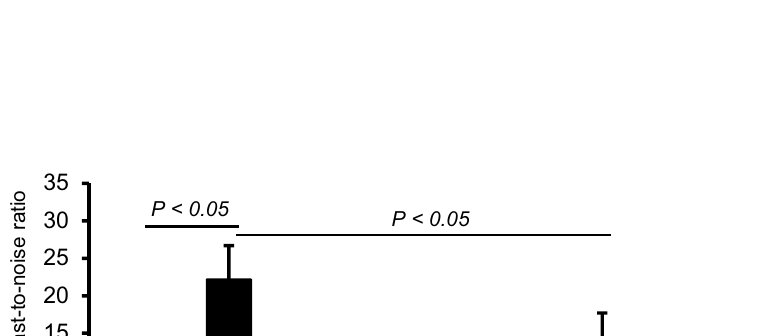
Figure 3. Laser ICP-MS for the assessment of the gadolinium distribution in the periablational rim. ( A1 , A2 ) Morphologic images show an overview of the location of the ablation zone, the periablational rim and the healthy liver tissue (( A2 ) magnification). ( B1 ) Gadolinium-specific LA-ICP-MS confirmed the high signal of the elastin-specific probe in the periablational rim (green signal). ( B2 – B4 ) Zinc, iron and phosphorous measurements were performed as a control. These elements did not show a specific distribution pattern in the periablational rim. Scale bars represent 500 mm.